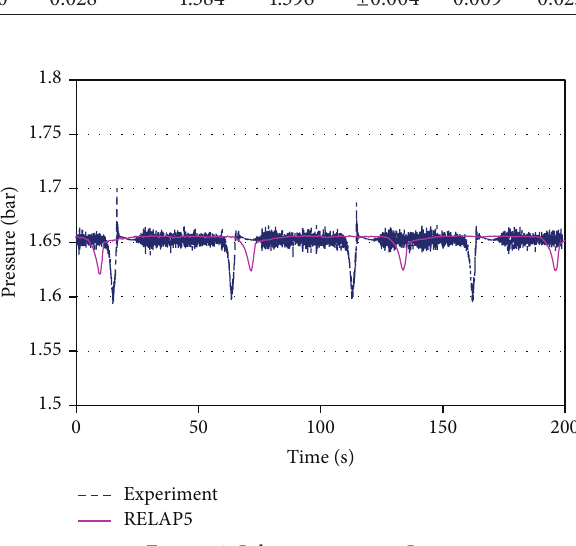
Figure 9: Inlet pressure, test